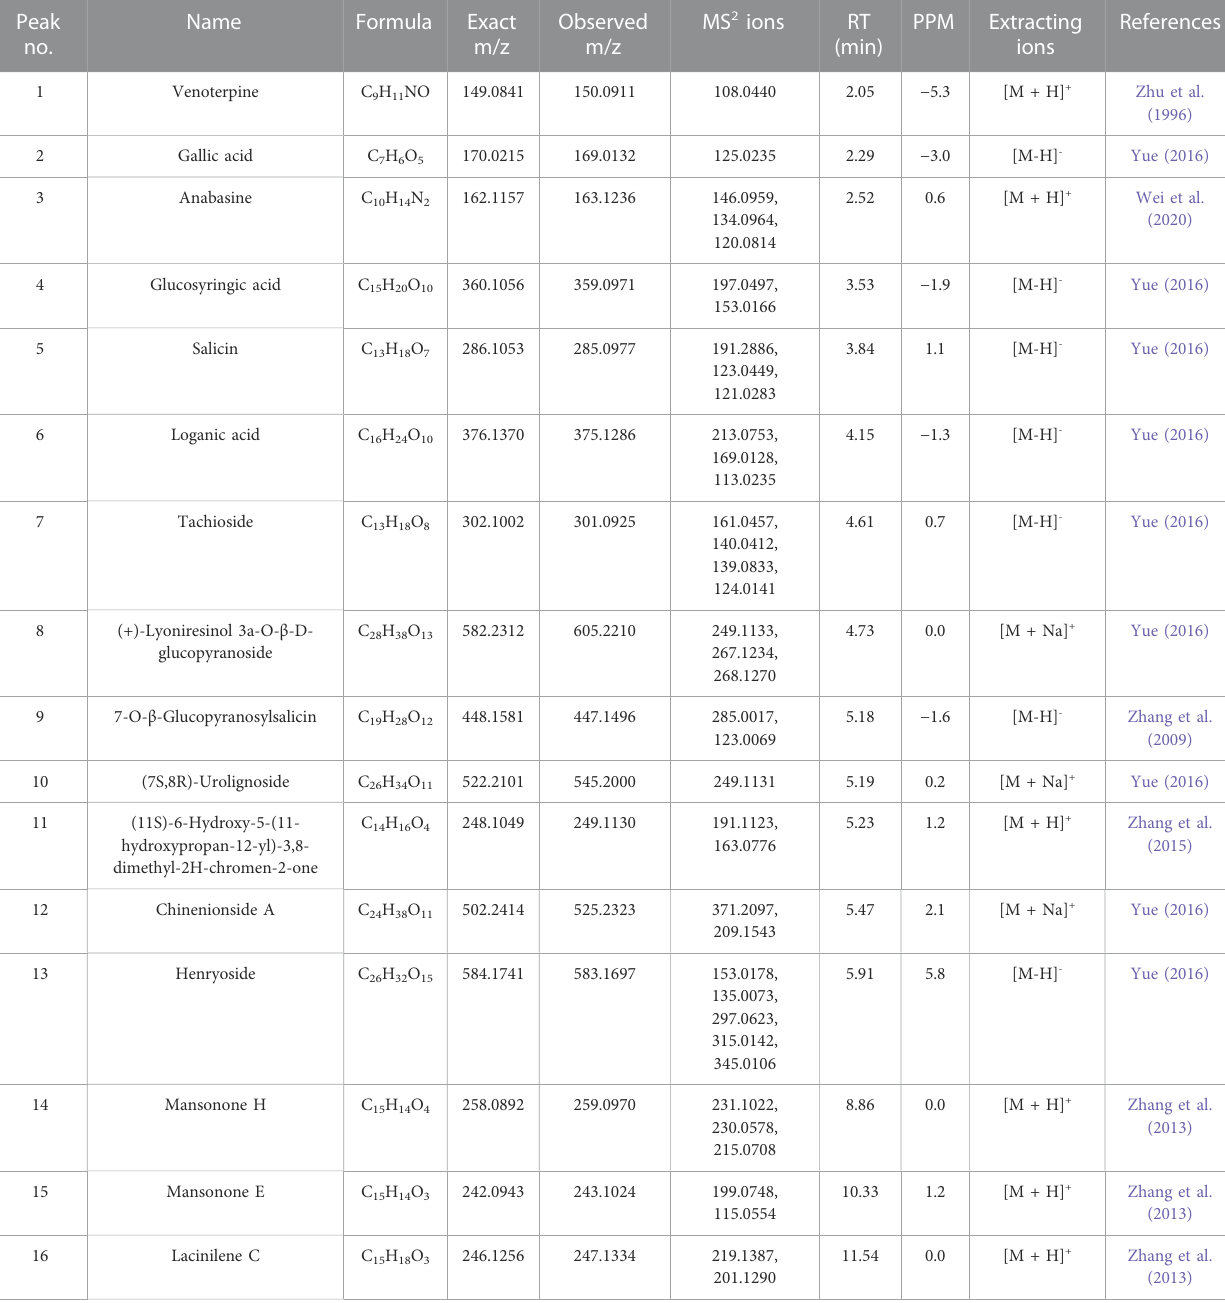
TABLE 2 The identi fi cation of constituents of the Alangium chinense extract (AC) by UPLC-Q-TOF-MS. Peak